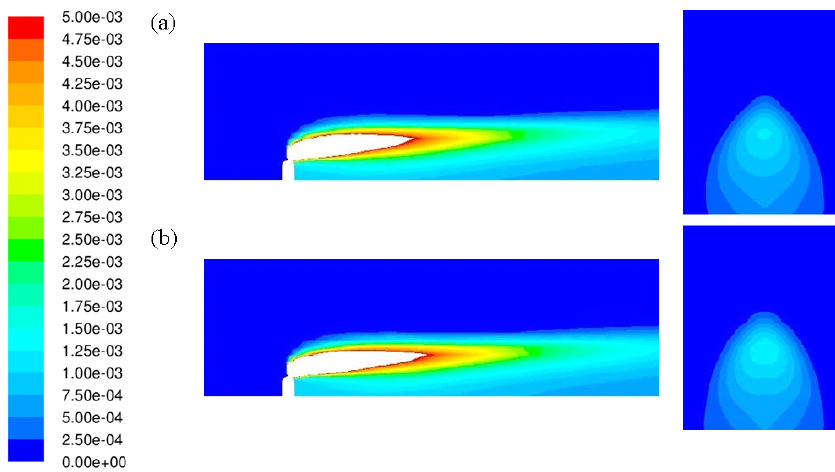
Fig. 9. Projections of 3-D pollutant concentration field: (a) constant velocity of the ambient flow: V = 0 . 25ms − 1 (b) logarithmic BBL profile V (y) = 0 . 241+0.049 ln(y)ms − 1 . Longitudinal view: vertical cross section passing through the port center (x=2.5m) and transversal view at a z-distance of 22m from the port. The unit of concentration is wt %.